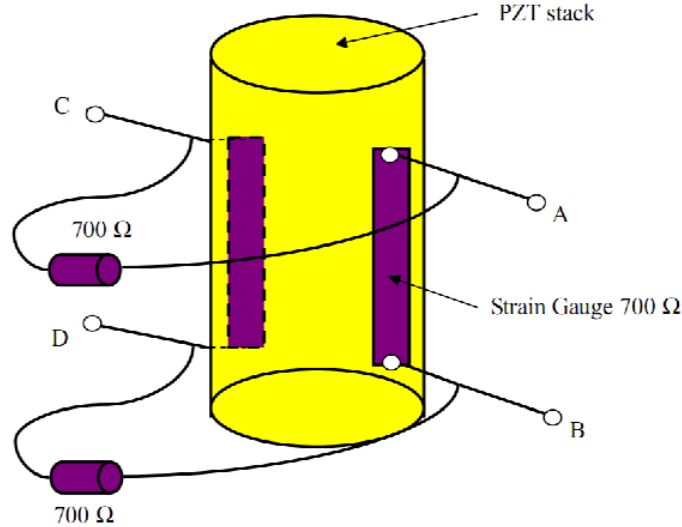
Figure 5. Measuring principle of the PZT stack position using SGS